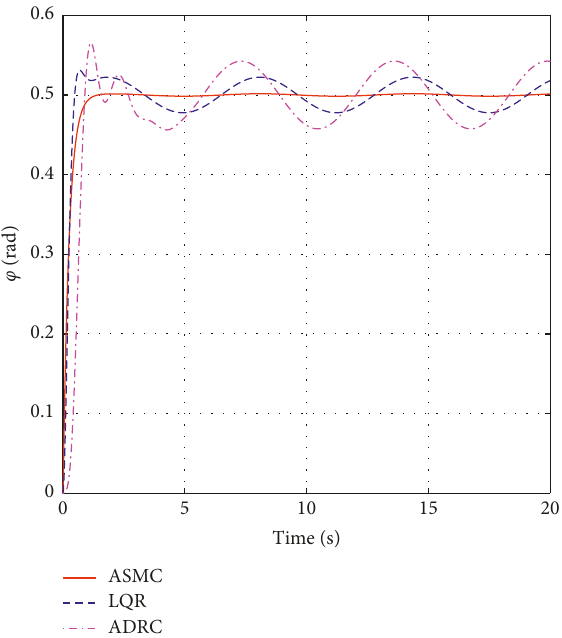
Figure 9: The tracking performance of yaw angle.